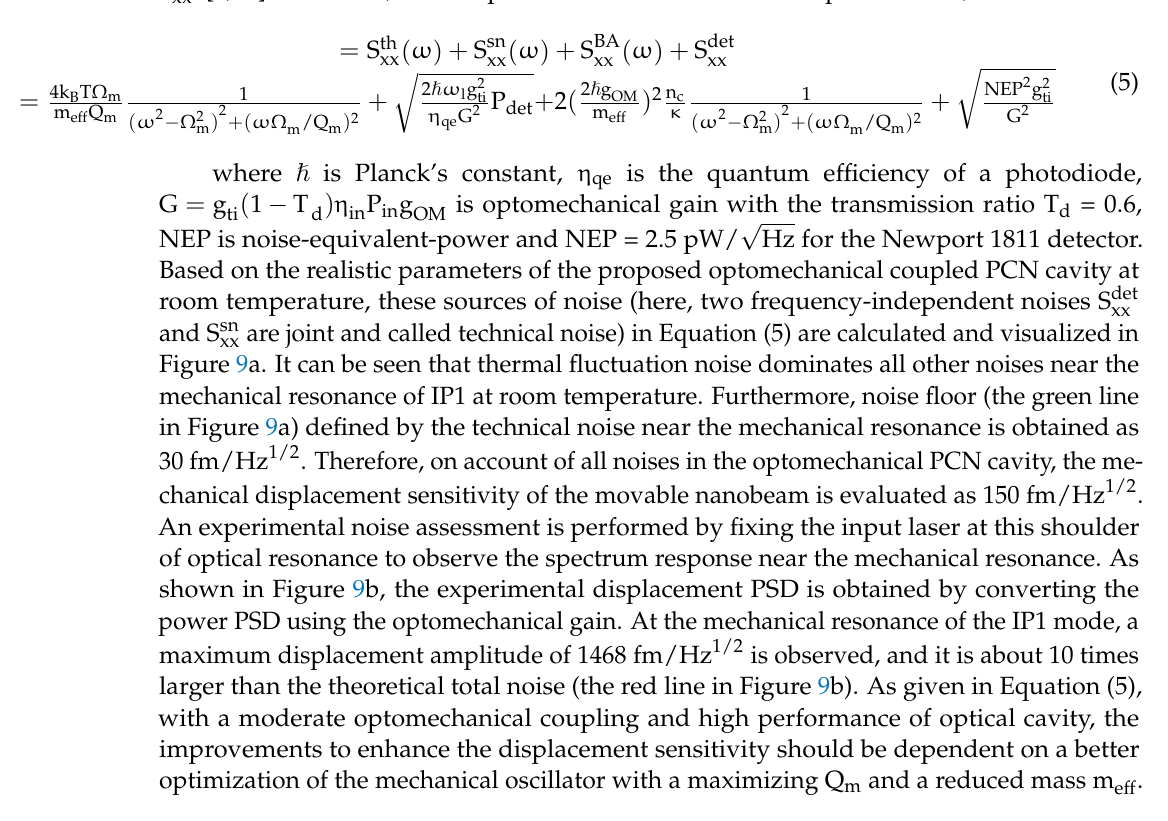
/2 π = 192.993 THz, cav /2 π = 151.6 GHz/nm, P in = 30 µ OM